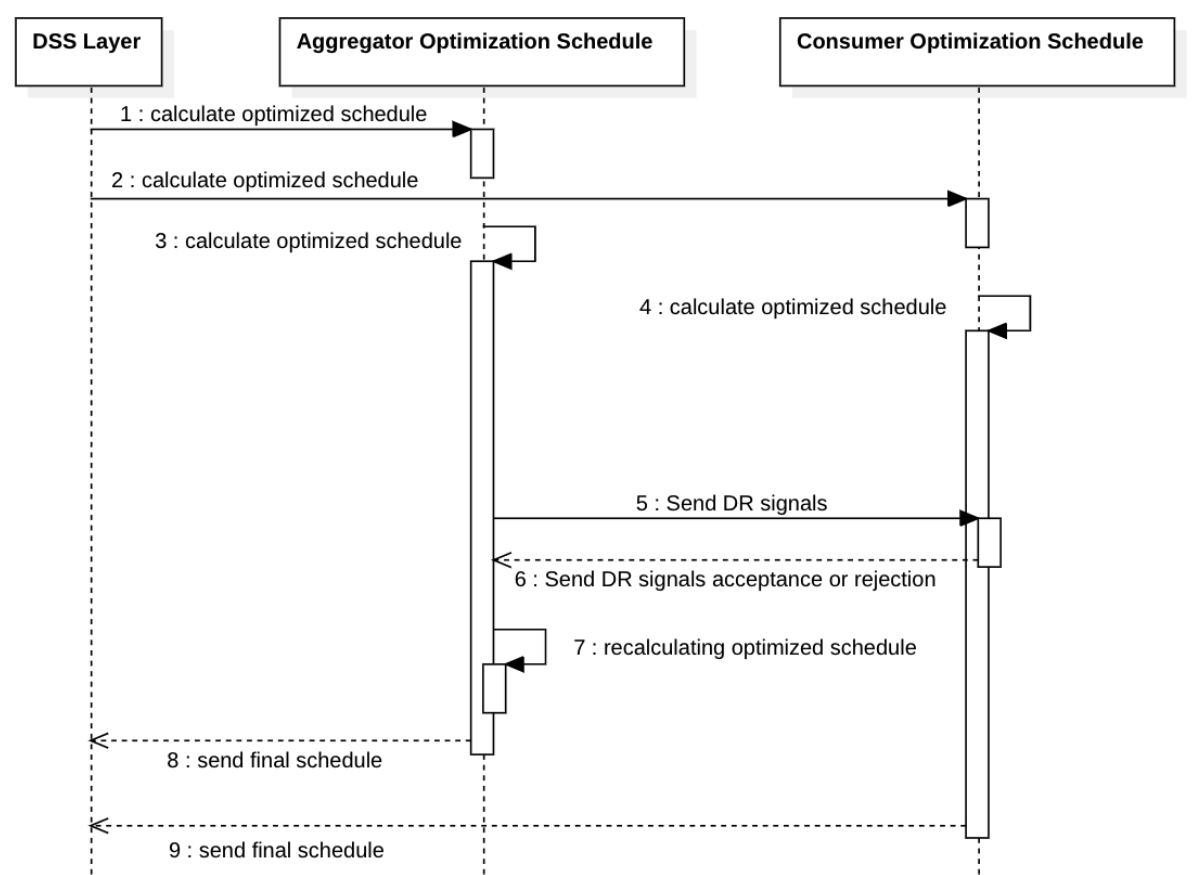
Figure 9. Proposed DR